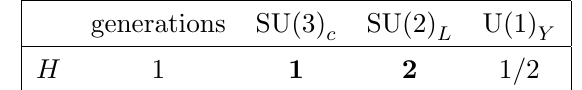
Table 1 . SM fermions and their charges under the SM gauge group.